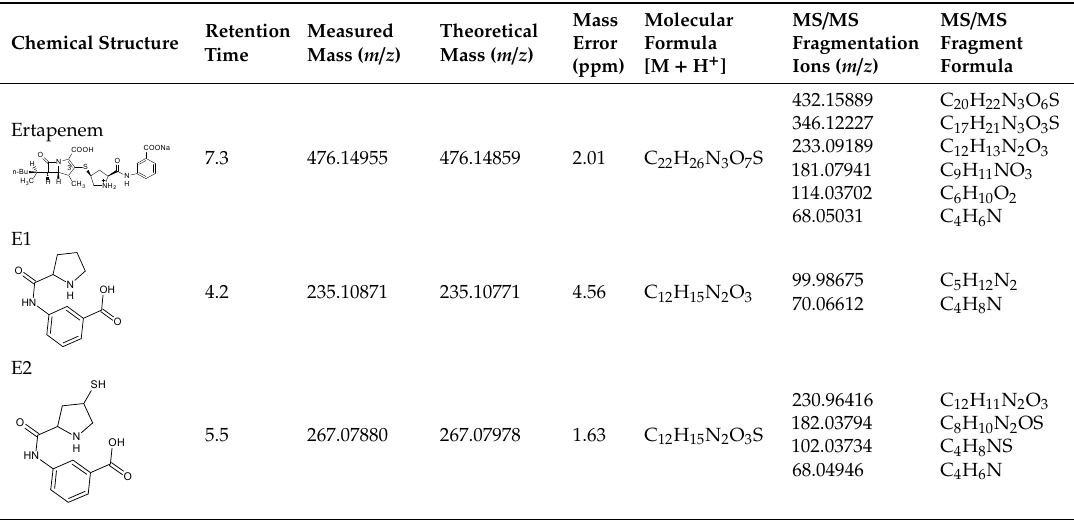
Table 4. Quadrupole time-of-flight ( Q-TOF) accurate mass elemental composition and mass spectrometry/mass spectrometry (MS/MS) fragmentation of the analyzed substances. Chemical Structure